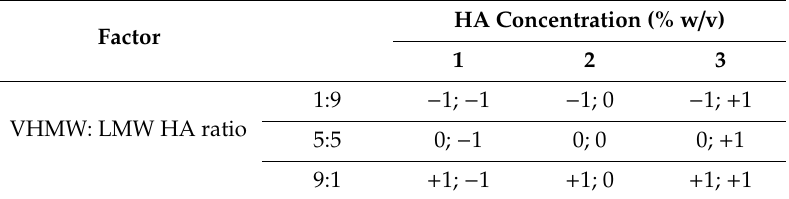
Table 1. Experimental points of the full factorial design. HA: hyaluronic acid, LMW: low molecular weight, VHMW: very high molecular